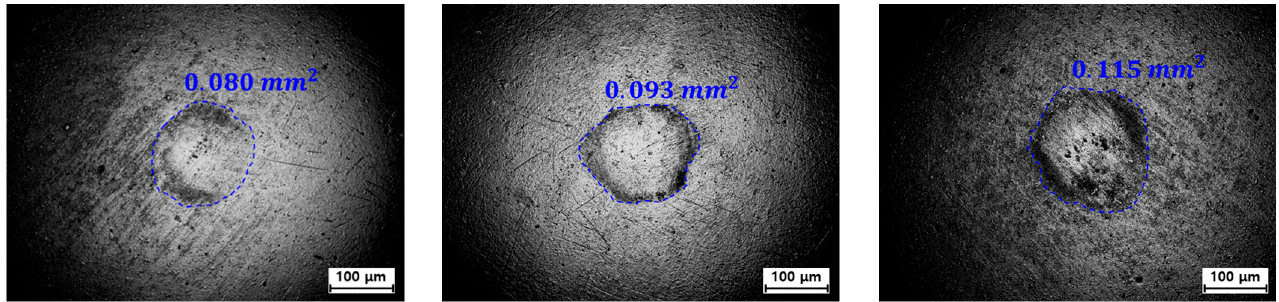
Figure 7. Wear area analysis of the pin measured by an optical electron microscope (OEM; F = 8 N, V = 60 rpm, L = 200 rev.).